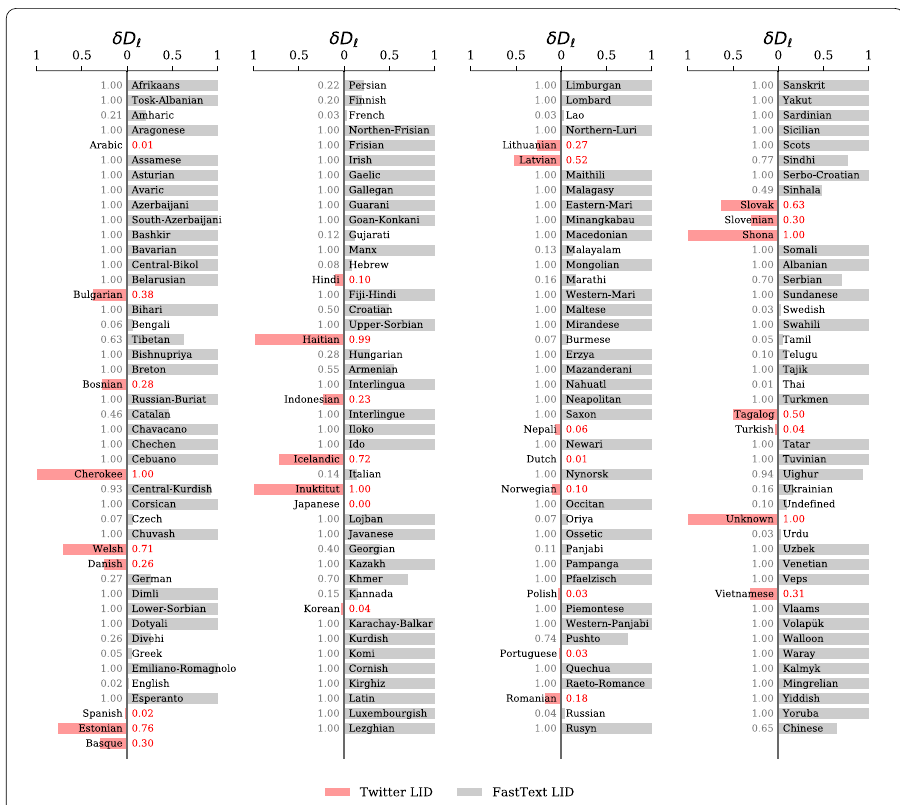
Figure 9 Language identification divergence. A normalized ratio difference δ D (cid:2) (i.e., divergence) closer to zero implies strong agreement, whereby both classifiers captured approximately the same number of messages over the last decade. Grey bars indicate higher rate of messages captured by FastText-LID, whereas red bars highlight higher rate of messages captured by Twitter-LID